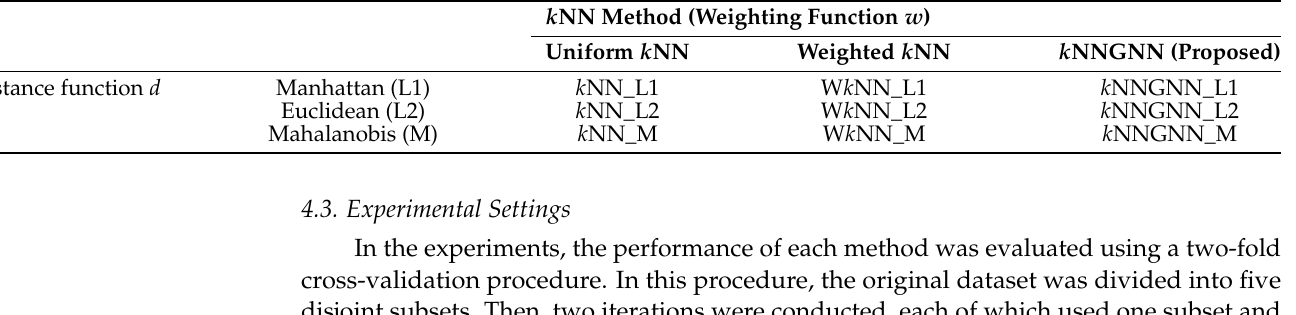
Table 3. Methods compared in the